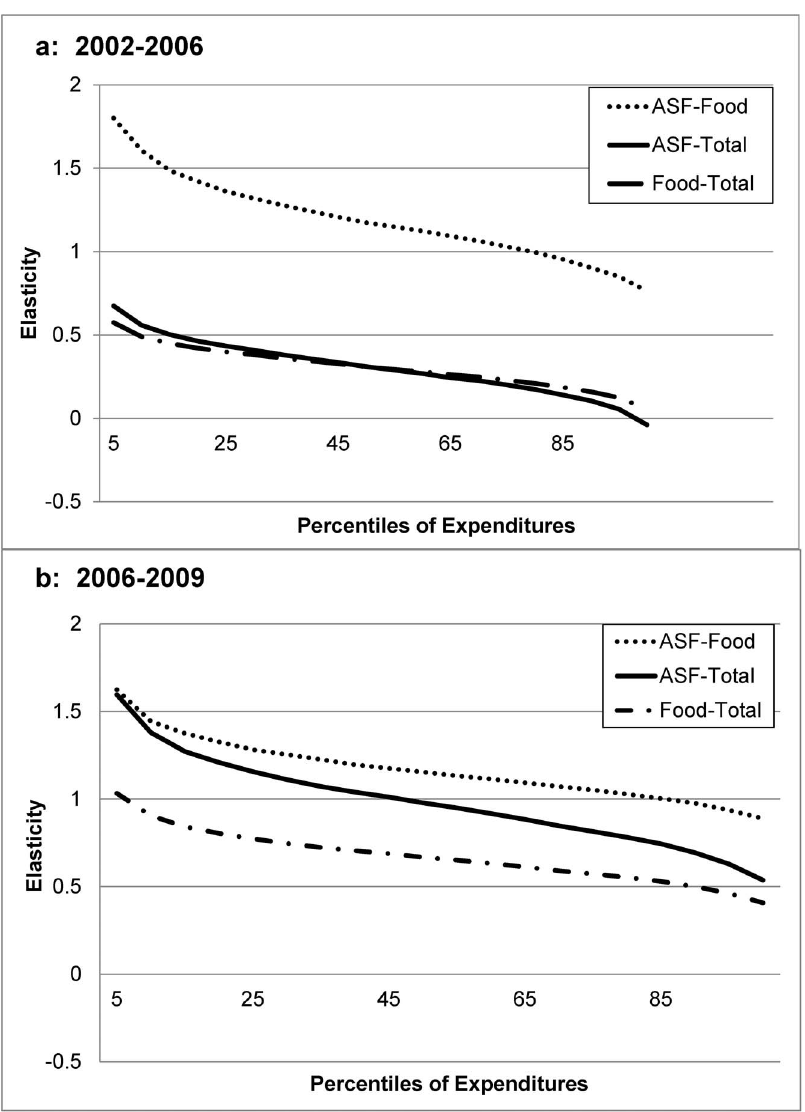
Figure 3. Elasticities of ASF and Food Expenditures with respect to Food or Total Expenditures. ( a ) From 2002–2006 elasticities are significantly different from 0 (p , 0.05) except for ASF-Total and Food-Total . 95 th percentile. All are significantly different from 1.0 (p , 0.05) except for ASF-Food between percentiles 65 and 80. ( b ) From 2006–2009 all elasticities are significantly different from 0 (p , 0.05). All are significantly different from 1.0 (p , 0.05) except for ASF-Food between percentiles 75 and 98, Food-Total below the 5 th percentile, and ASF-Total between percentiles 35 and 45.